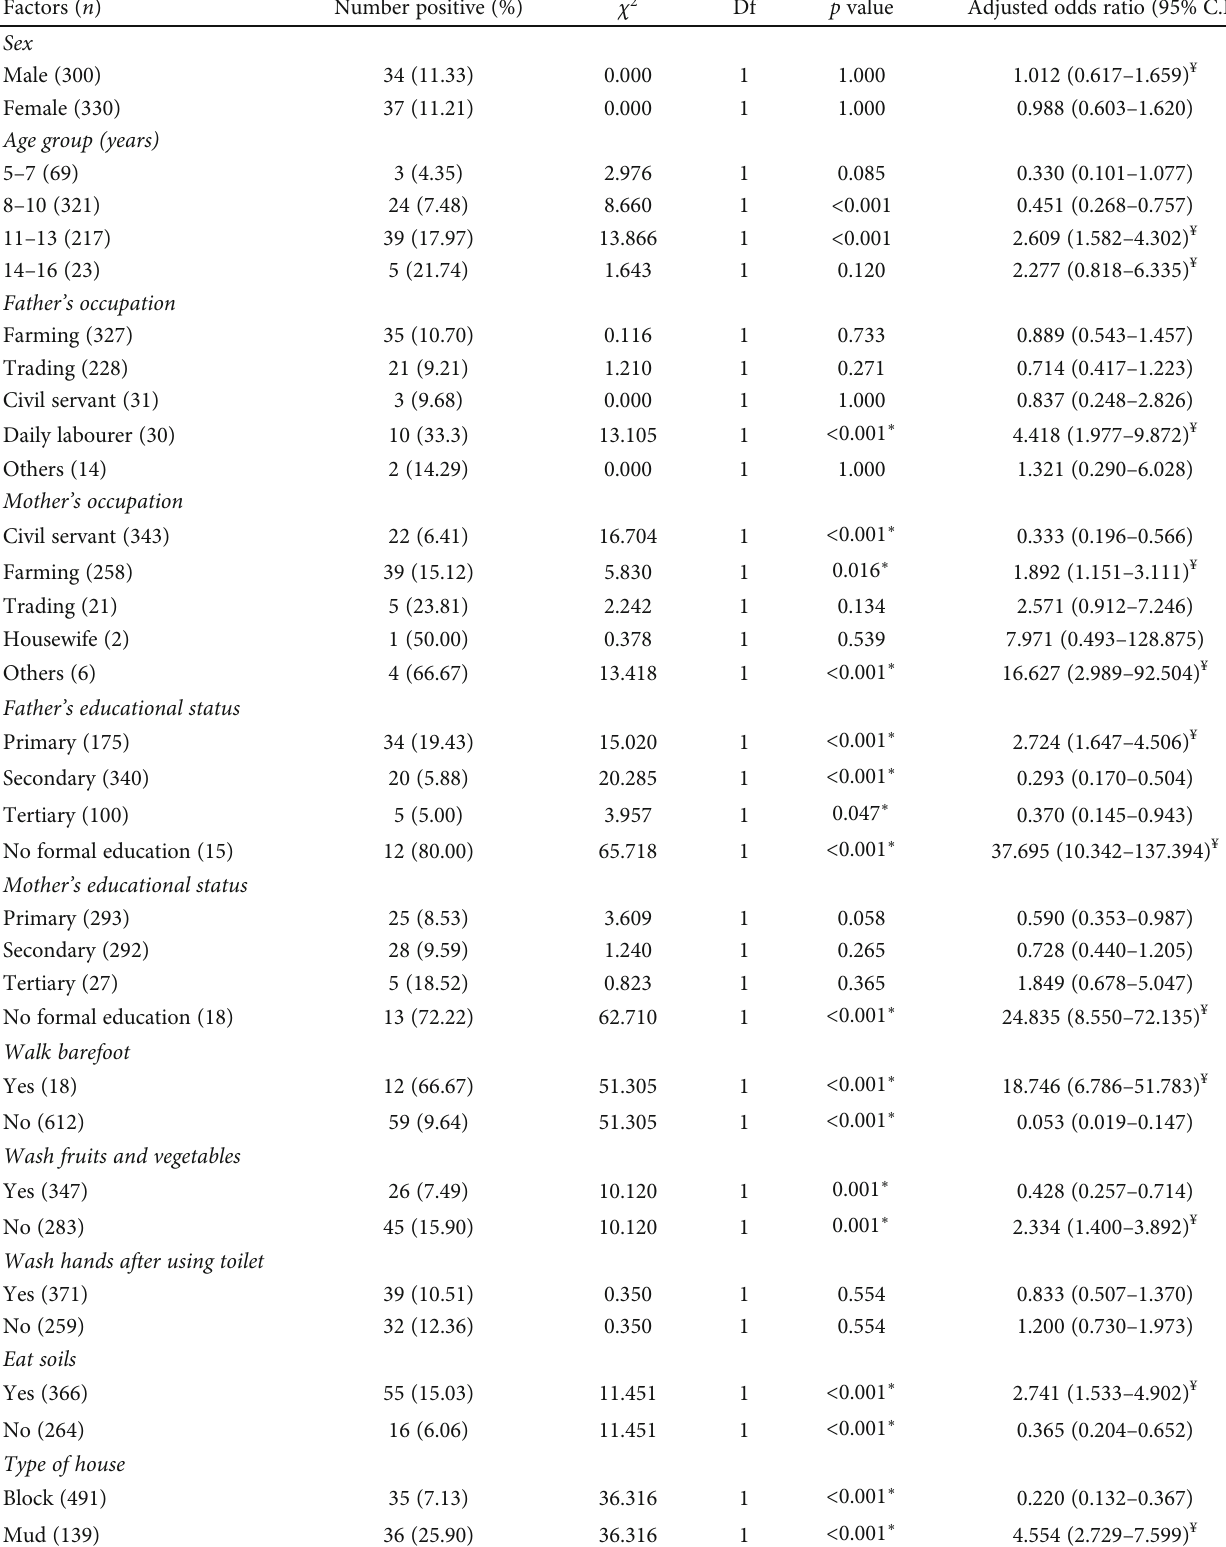
Table 6: Bivariate and multivariate analysis of risk factors associated with STHs among school children in Biase